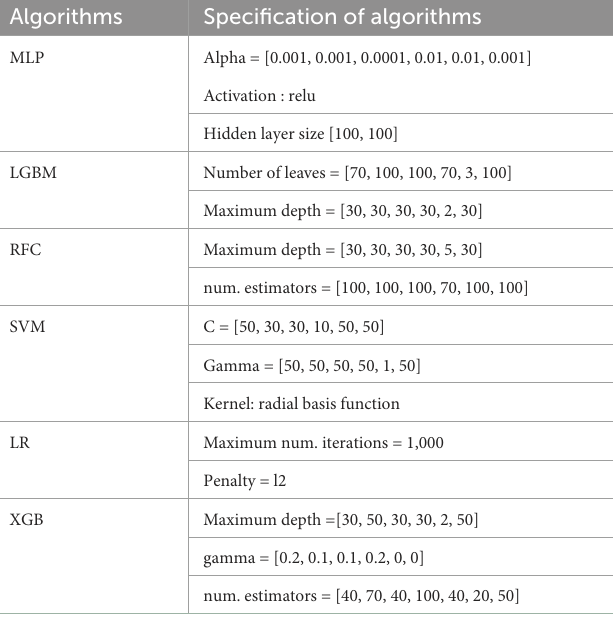
TABLE 3 Detailed specifications for the six algorithms. TABLE 4 Some metrics for the evaluation of a classifier based on the confusion